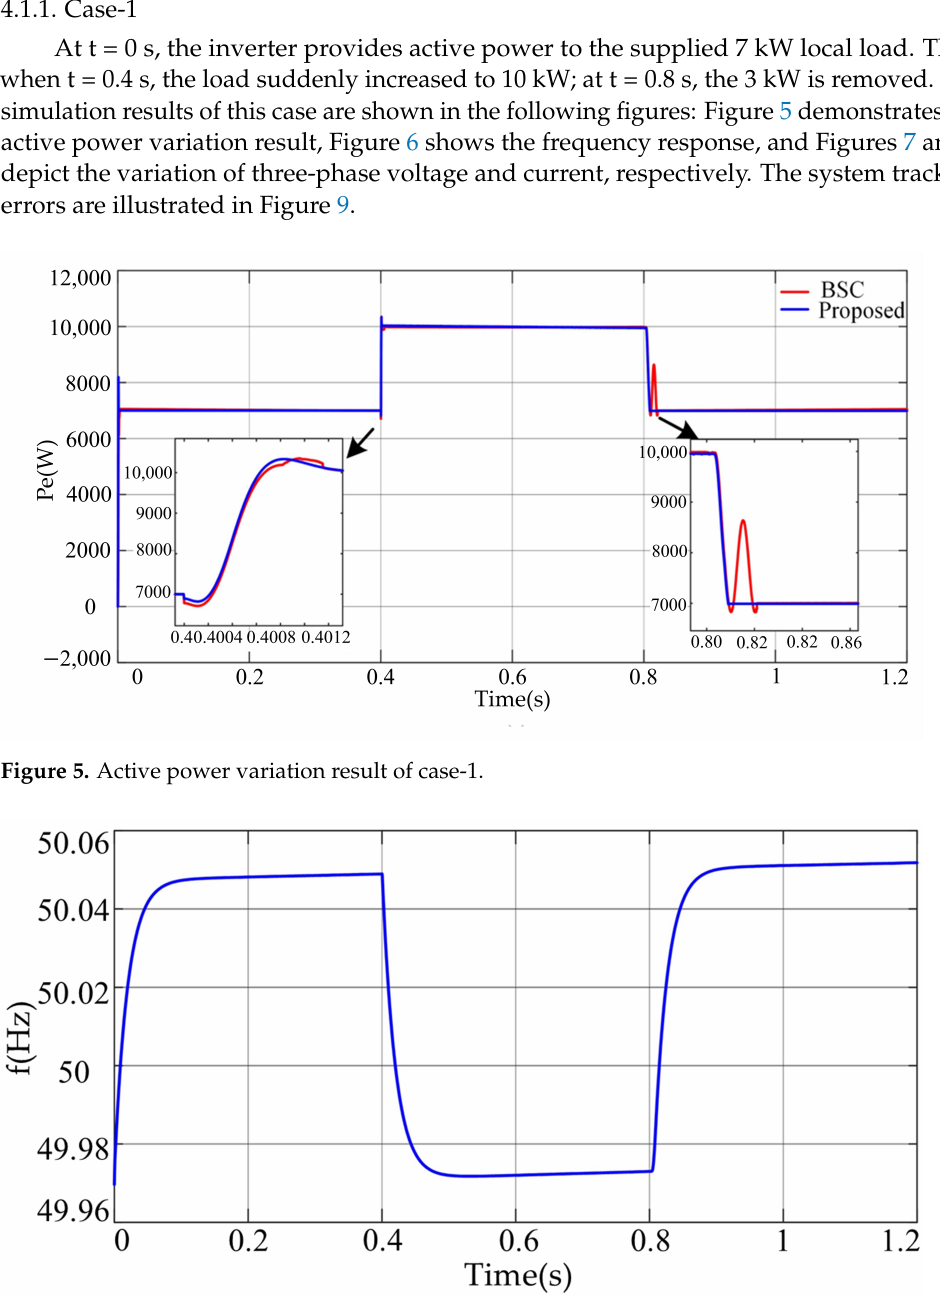
Figure 6. Frequency variation result of